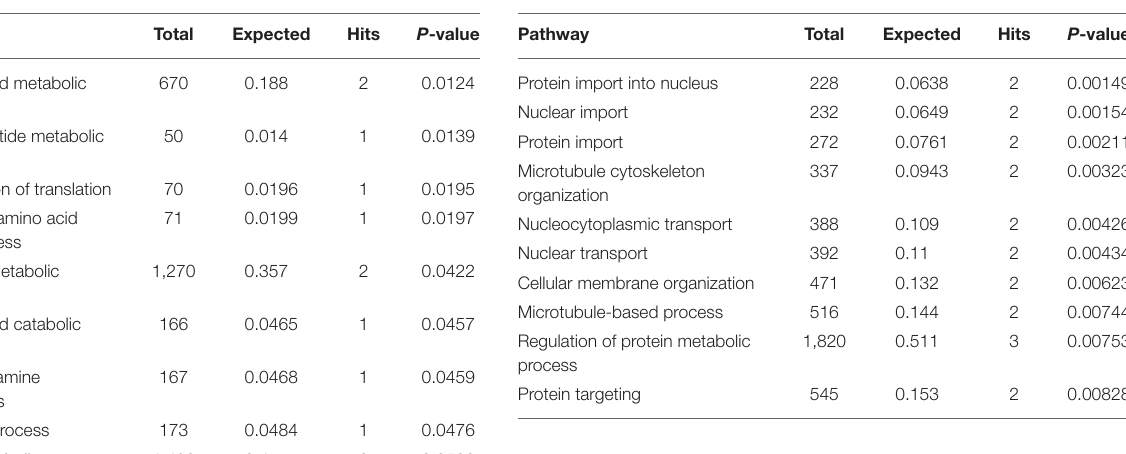
TABLE 4 | Pathways enriched by proteins and metabolites in subnetwork 4 of the protein–metabolite interaction network based on the GO:BP